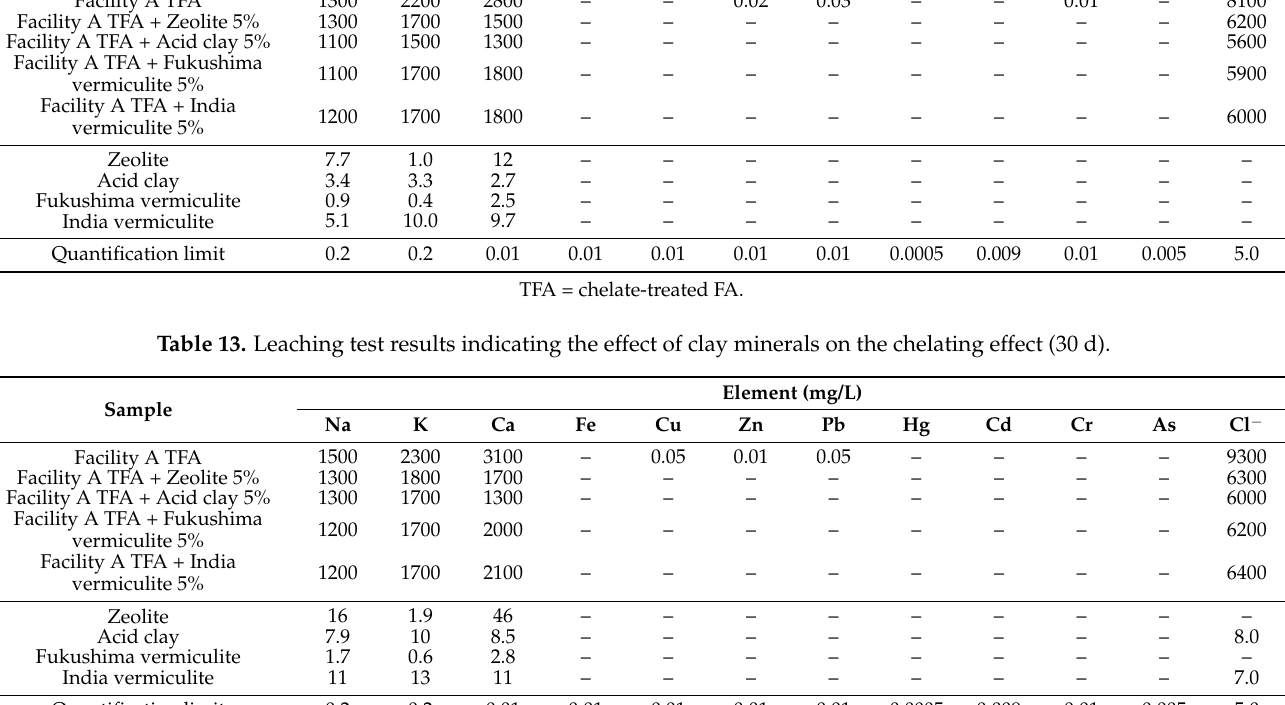
Table 12. Leaching test results indicating the effect of clay minerals on the chelating effect (6 h). Sample